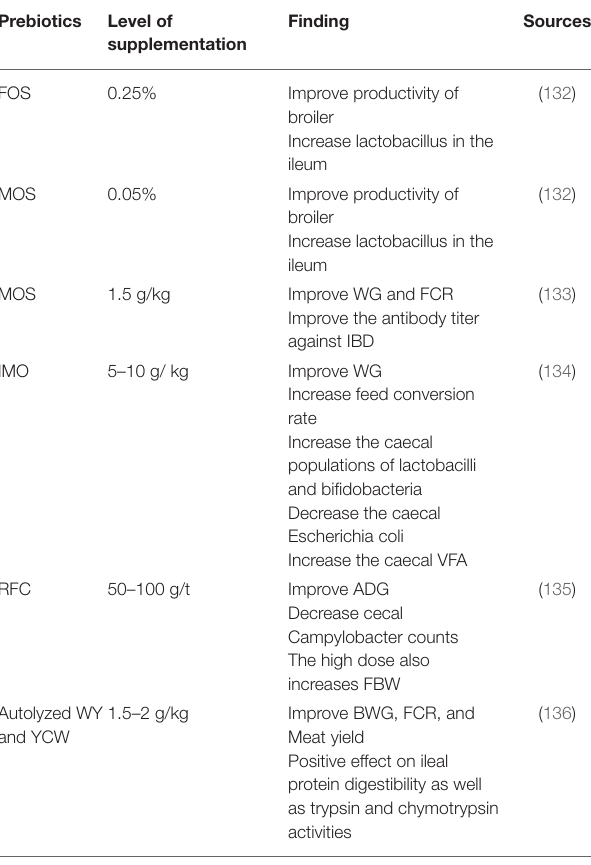
TABLE 3 | Prebiotics and their ameliorative effects on broiler